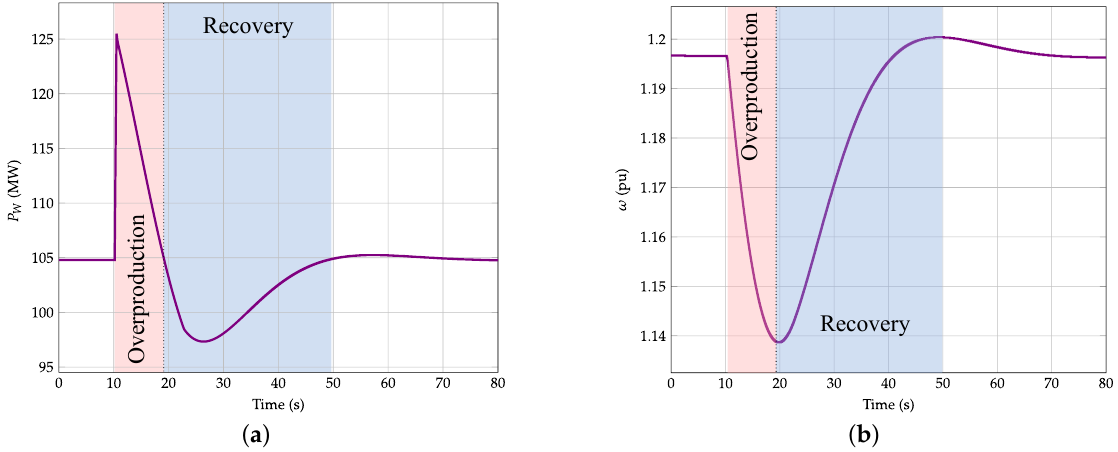
Figure 6. Example of overproduction and recovery periods. ( a ) Electrical power (MW); ( b ) Rotational speed (pu).